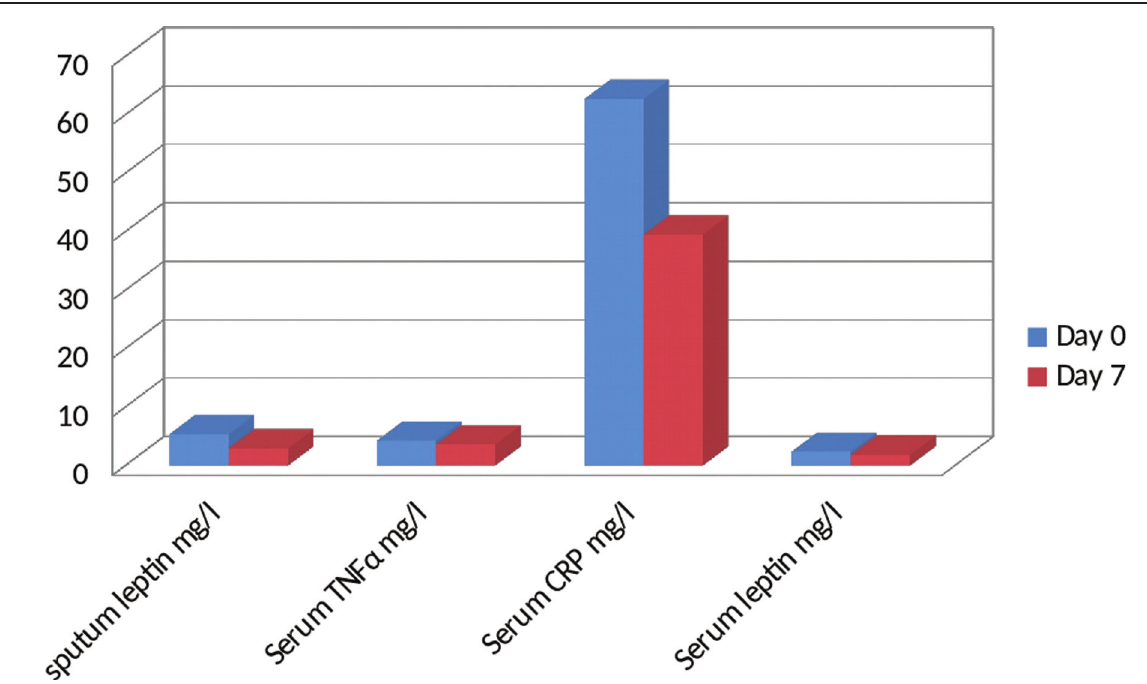
Correlation between sputum leptin, serum TNF- α , CRP, and leptin levels in group 1 patients with AECOPD on day 0 and day 7 after treatment. AECOPD, acute exacerbation of chronic obstructive pulmonary disease; CRP, C-reactive protein; TNF- α , tumor